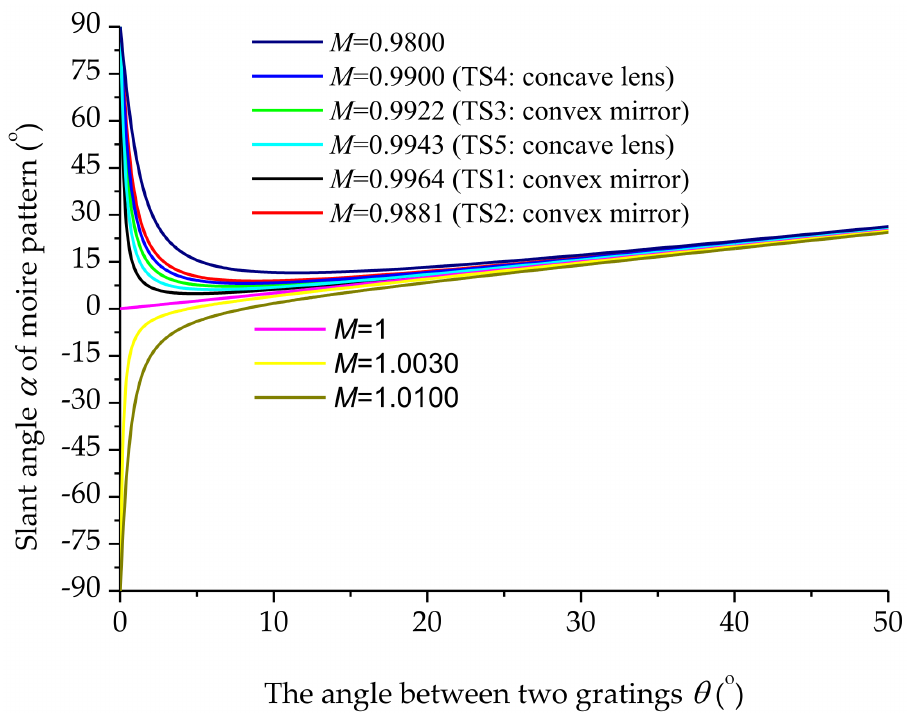
Figure 5. The relationships between the slant angle α of moir é pattern and the angle θ between practical and digital